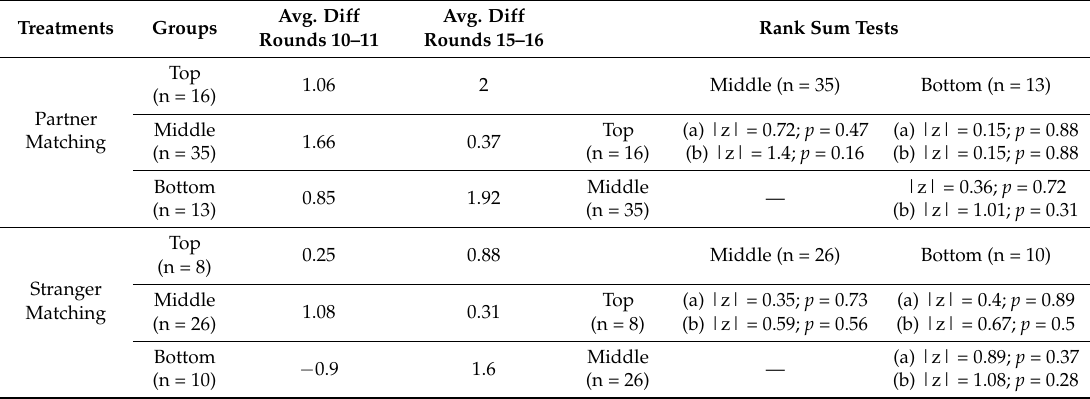
Table A2. Rank sum tests comparing contributions differences between Rounds 10–11 and Rounds 15–16.